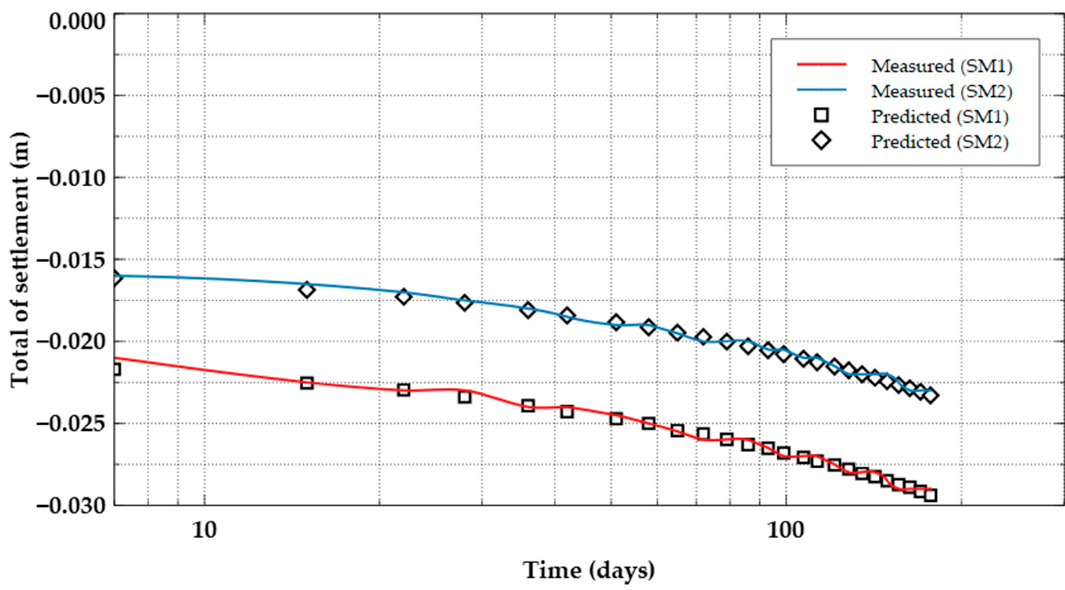
Figure 10. Settlement behaviour performance between two locations.